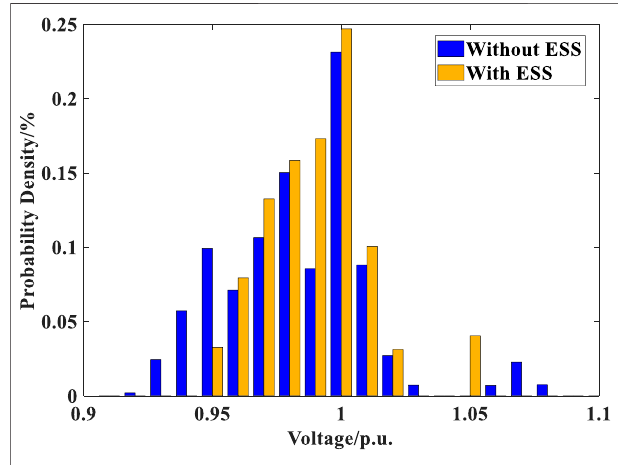
FIGURE 8 | Histograms of node voltage (p.u.) across the network without or with the ESS deployment in a